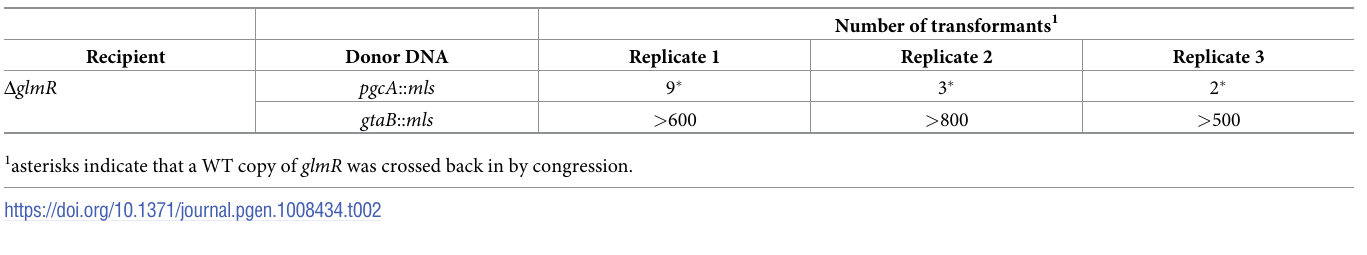
Table 2. Transformation of pgcA :: mls and gtaB :: mls into recipient Δ glmR